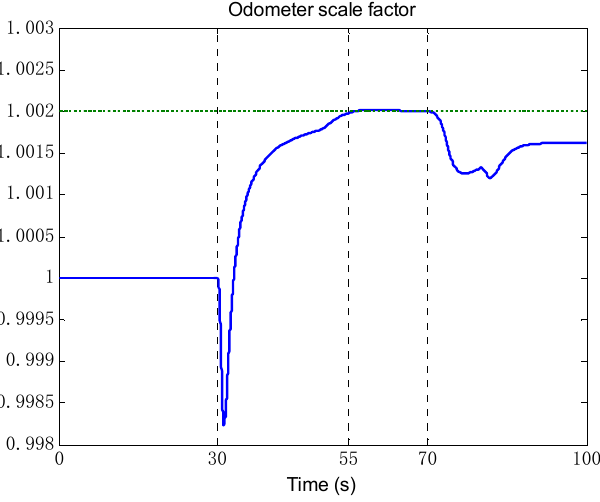
Figure 4. The estimation of odometer scale factor. The blue solid line denotes the estimation by self-calibration algorithm, and the green dashed line denotes the truth value.